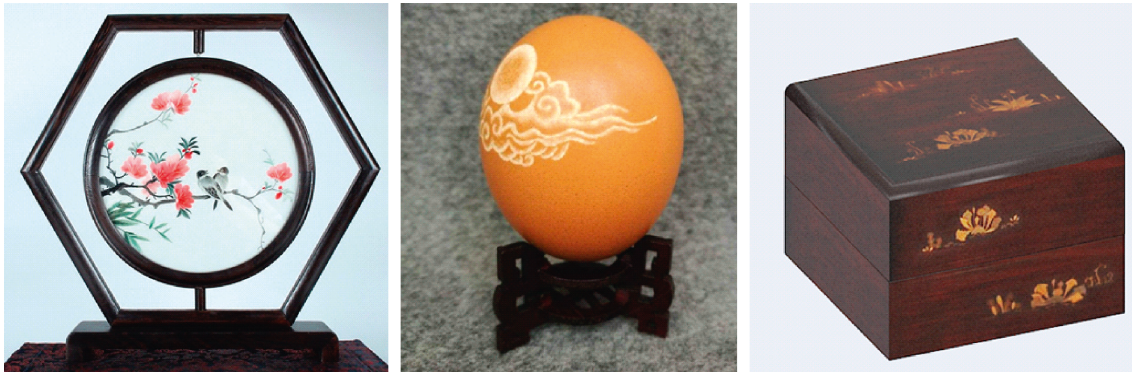
Figure 5: Traditional